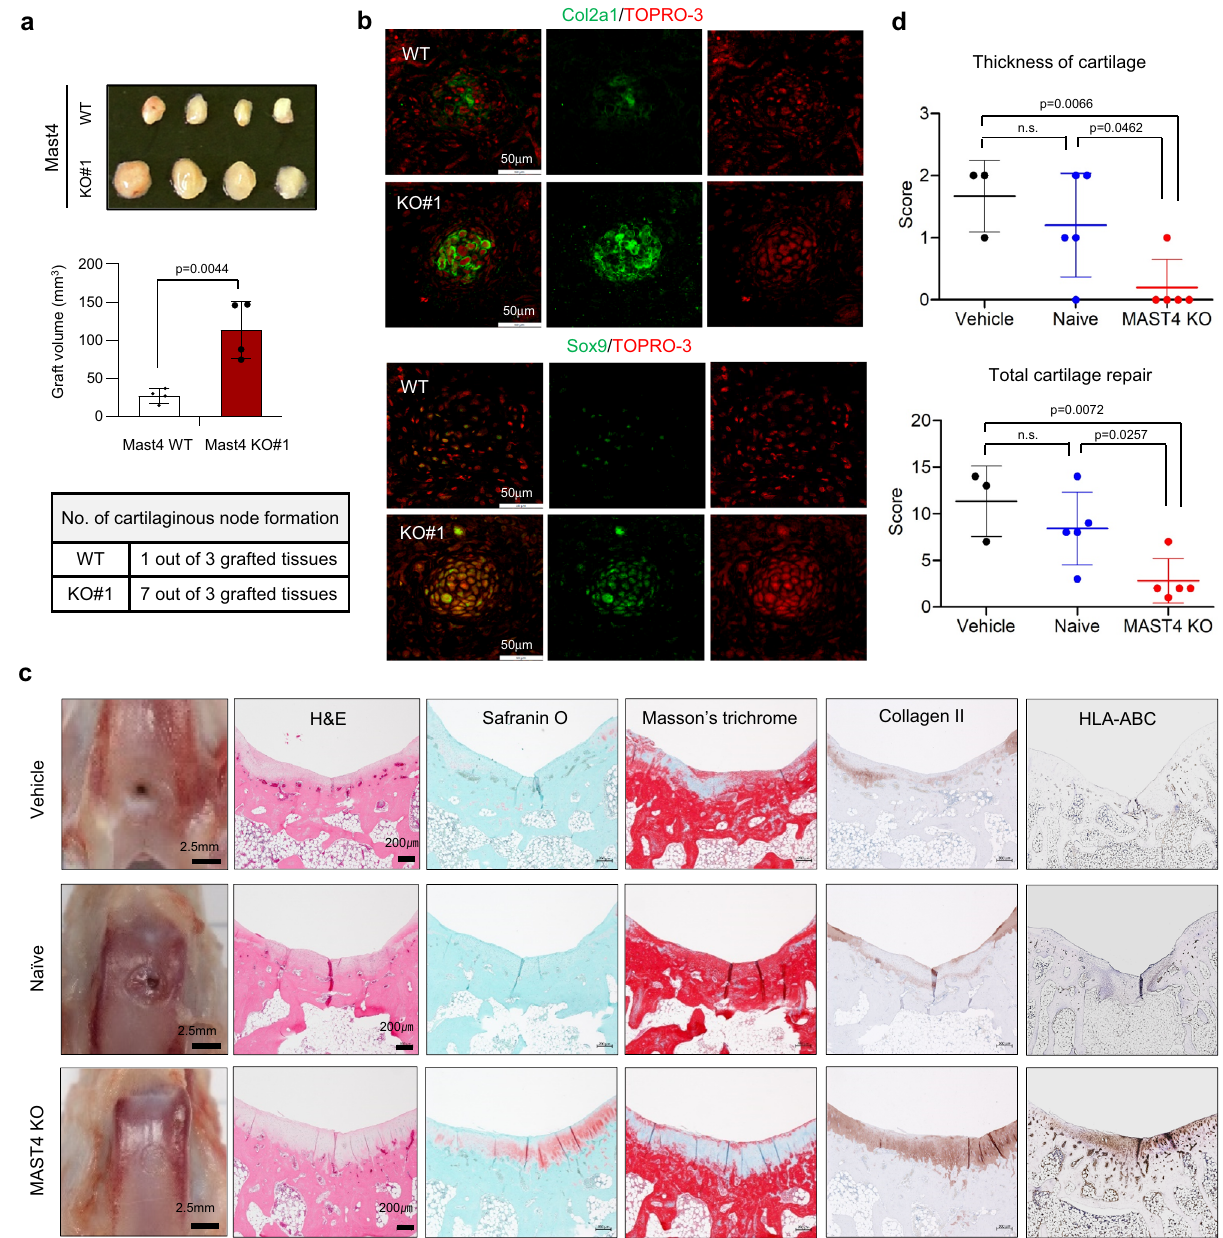
Fig. 7 Transplantation of Mast4-depleted MSCs improves cartilage formation and repair in vivo. a A hundred micromass cultures of the wild-type and Mast4-depleted C3H10T1/2 cells cultured in a 150 mm dish with chondrogenic differentiation medium for 4 days were subcutaneously injected into each side of the fl anks of athymic nude mice ( n = 4; WT on the left fl ank and KO on the right fl ank). Ectopic masses were retrieved at 2 weeks after implantation. The values given are mean ± SD of the volume of grafts from 4 mice. Unpaired two-tailed Student ’ s t test ( P < 0.05) was conducted for statistical analysis. b Multiple cartilage structures found in the grafts of wild-type and Mast4-depleted C3H10T1/2 cells were con fi rmed by immuno fl uorescence staining of Col2a1 and Sox9. Merge of Sox9 and TOPRO-3 is shown in yellow. The representative images were obtained from immunostainings of 1 cartilaginous node formed by wild-type C3H10T1/2 cells and 7 different cartilaginous nodes formed by Mast4-depleted C3H10T1/2 cells. c Gross and microscopic appearances of full-thickness cartilage defects in the trochlear groove in a rabbit model at 12 weeks post-transplantation. Vehicle: PBS treatment without hBMSC transplantation. d Wakitani cartilage repair scores of the regenerated cartilage. Data are represented as mean ± SD. c , d n = 3 for vehicle-treated group, n = 5 for naïve and MAST4-depleted hBMSC-transplanted groups. One-way ANOVA with Dunnett ’ s correction for multiple comparisons was conducted for statistical analyses for d . Source data for a , d are provided as a Source Data fi